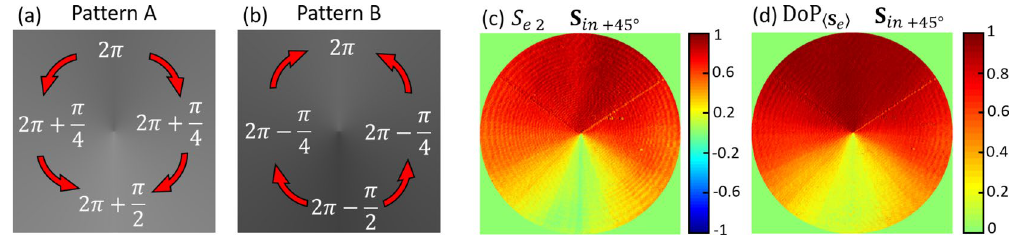
Figure 7. ( a , b ) Phase pattern images encoding a spiral distribution, with indication of the phase levels. The red arrows denote the sense where the phase increases. ( c ) Experimental effective Stokes parameter S e 2 when the 45 ◦ and ( d ) experimental effective DoP incident beam is linearly polarized at +